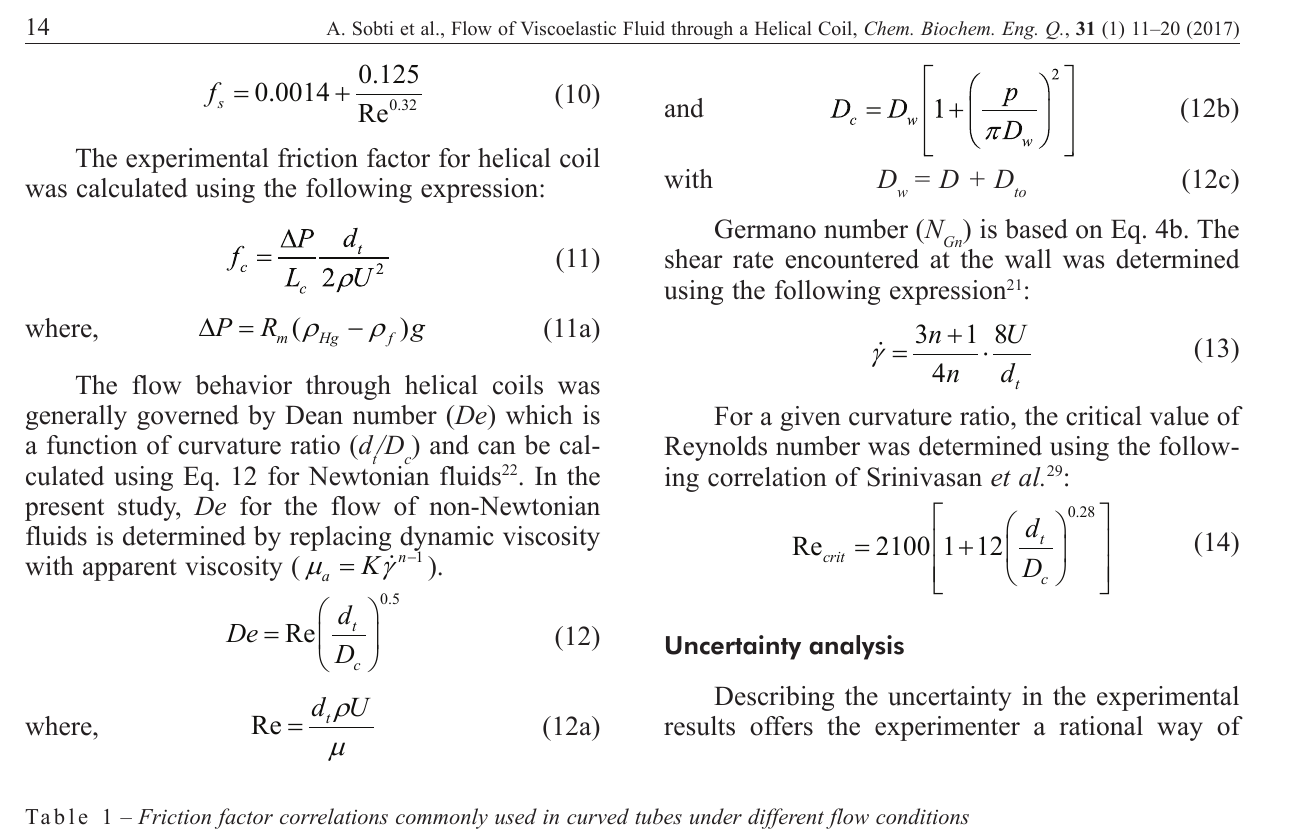
– Experimental correlation for single as well as two-phase flow of non-Newtonian viscoinelastic fluids. Effect of helix angle was determined under laminar and turbulent flow conditions